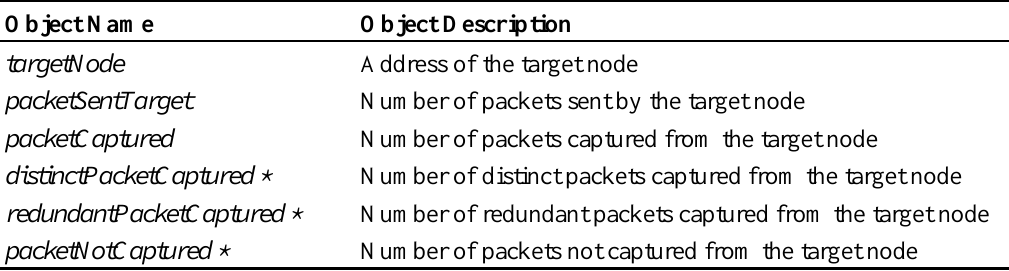
Table 5. Objects represented in the monitorNetworkTable